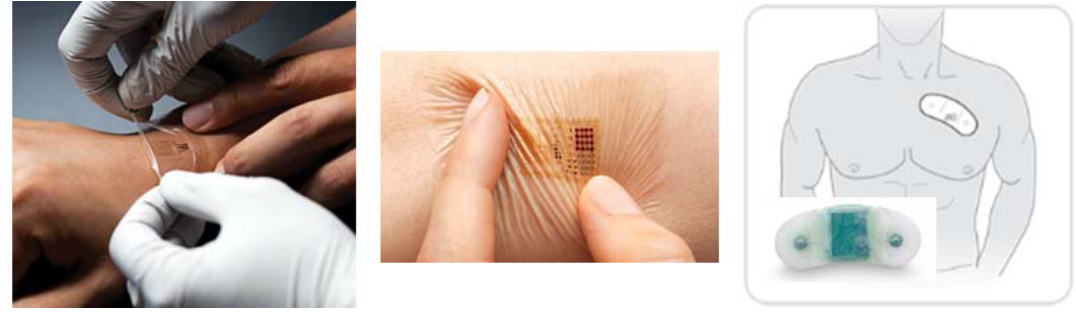
Figure 5. Continuous Wearable Sensor Patches for Blood Chemistry and Vital Signs (mc10) and Cardiac Rhythm (iRhythm’s Zio